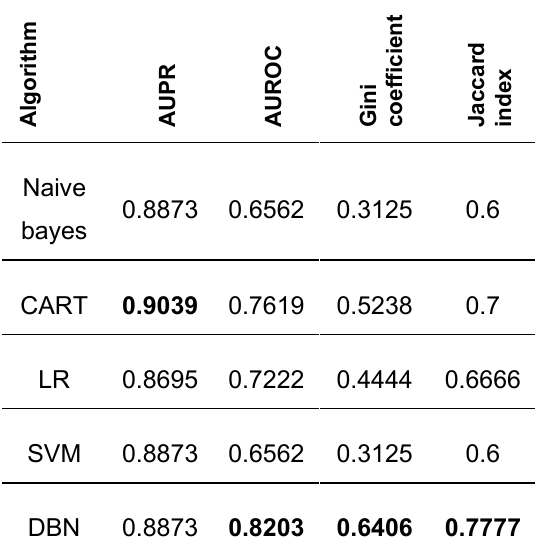
Table 8. Tabulation of evaluation measures obtained for all the